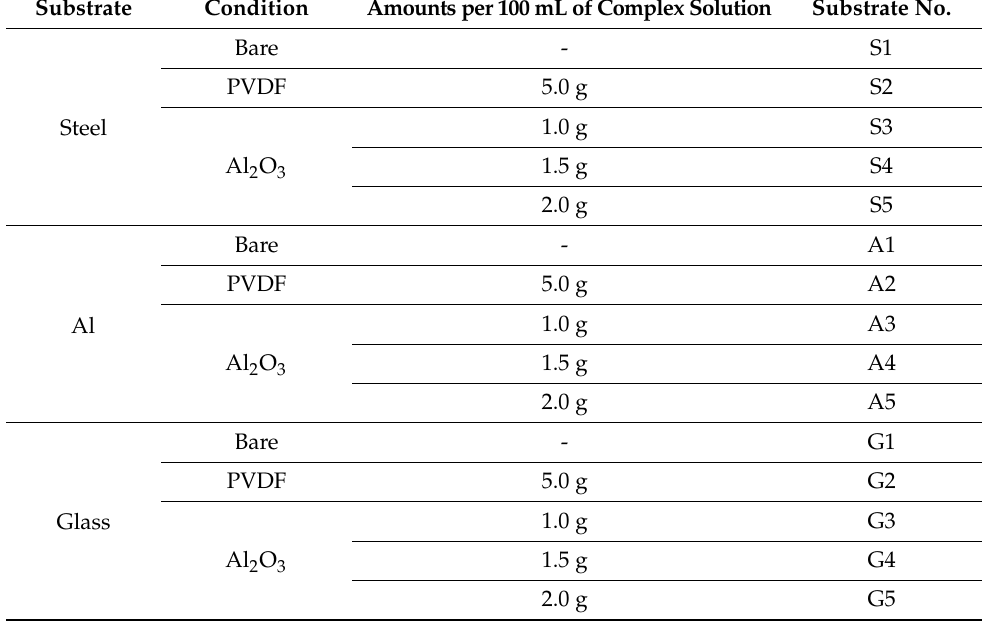
Table 1. Experimental